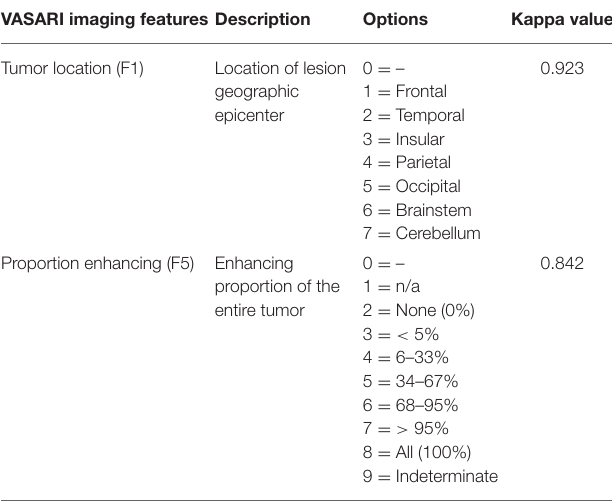
TABLE 3 | Inter-observer analysis for VASARI imaging features used in the study. VASARI imaging features